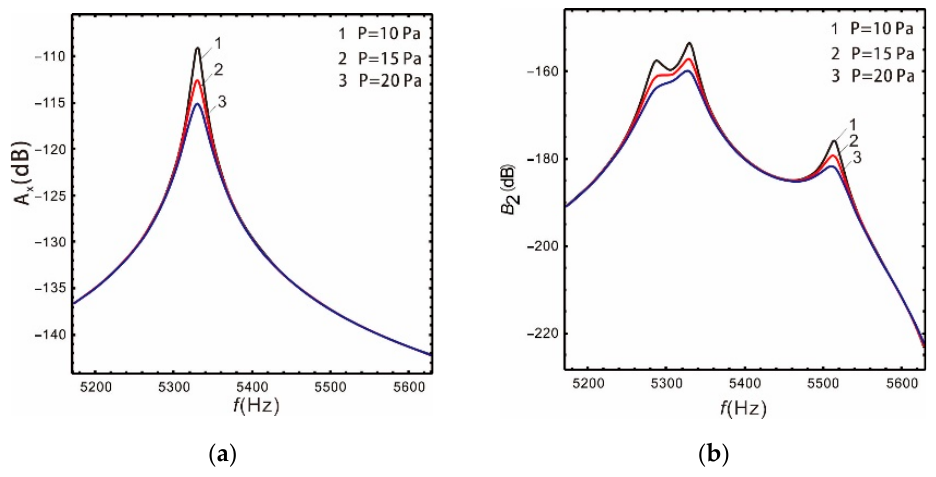
Figure 11. Influence of damping on the linear micro-gyroscope: ( a ) drive mode; ( b ) sense mode.